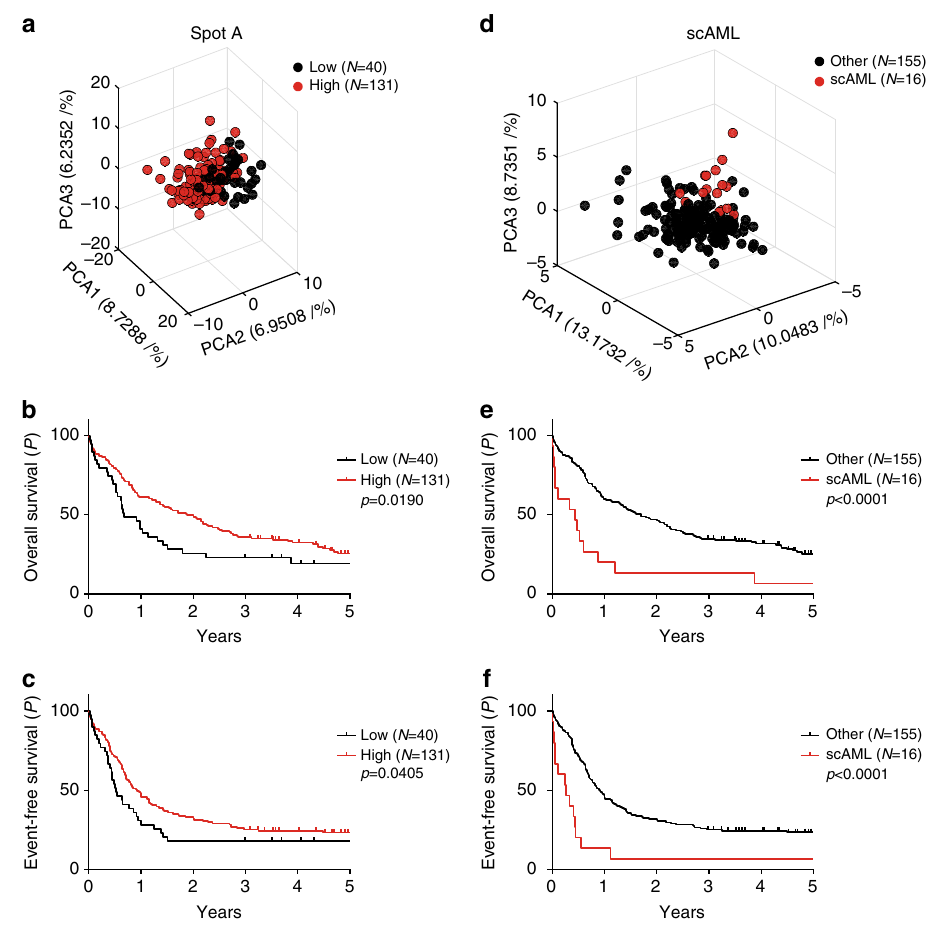
Fig. 7 ncRNA stem cell signatures predict survival in adult AML. a PCA of 171 adult AML samples 38 using the Spot A signature (Supplementary Data 7). b Kaplan – Meier curves of 5-year overall survival and c event-free survival of AML patients, grouped via unsupervised k-means clustering according to their expression of Spot A ncRNAs. d PCA of adult AML samples using the differentiation-associated SC-AML signature (Supplementary Data 7). e Kaplan – Meier curves of 5-year overall survival and f event-free survival of the stem cell AMLs (SC-AML) in comparison to the other AMLs, as separated by unsupervised k-means clustering. P -values were calculated using the log-rank